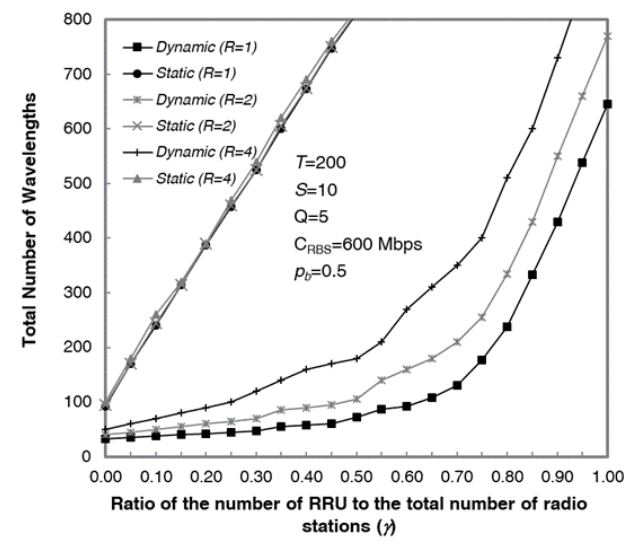
Figure 5. Comparison of the total number of wavelengths for the static and dynamic scenario cases. The total number of wavelengths is reported as a function of the used RRU percentage in the case of number R of optical rings equal to 1, 2 and 4. The residential and business sub-area probabilities p r and p b are chosen equal to 0.5 and their peak offered traffic in the PHI are A o , b = 26 Gbps and A o , r = 16 Gbps. The reference area is composed of T = 200 sub-areas and each optical ring interconnects S = 10 Access Switches, each one handling the traffic of D = T sub-areas. Each RRU can chose one SR of Q = 5 MIMO configurations according to the offered traffic. The configurations provide the user capacities C RRU = 0, C RRU = 75 Mbps, C RRU = 150 Mbps, C RRU = 300 Mbps and C RRU = 600 Mbps 0 2 3 1 4 and generate CPRI traffic flows at bit rate f CPRI = 0 Gbps, f CPRI = 1.2288 Gbps, f CPRI = 2.4576 Gbps, 0 2 1 f CPRI = 4.8152 Gbps and f CPRI = 9.8304 Gbps, respectively. An OTN with two layers (ODU2 and 3 4 ODU4) is considered with wavelengths carrying 100 Gbps flows.